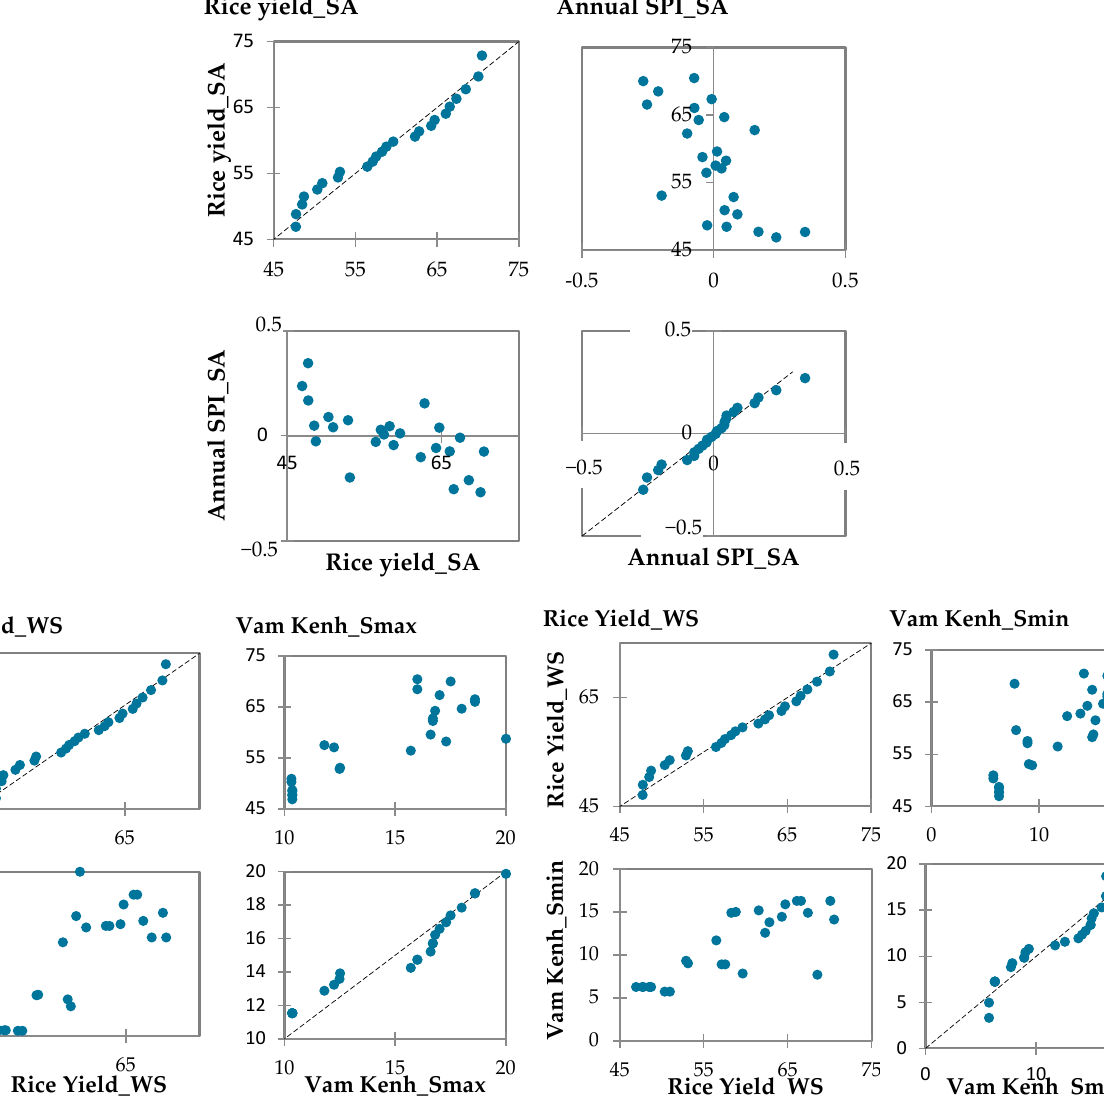
Figure 7. The Pearson correlation between mean rice yield in the summer-autumn rice cropping season and winter-spring rice cropping season with annual SPI season (SA and WS) and salinity at coastal stations (Vam Kenh, Tra Vinh, and Xeo Ro).